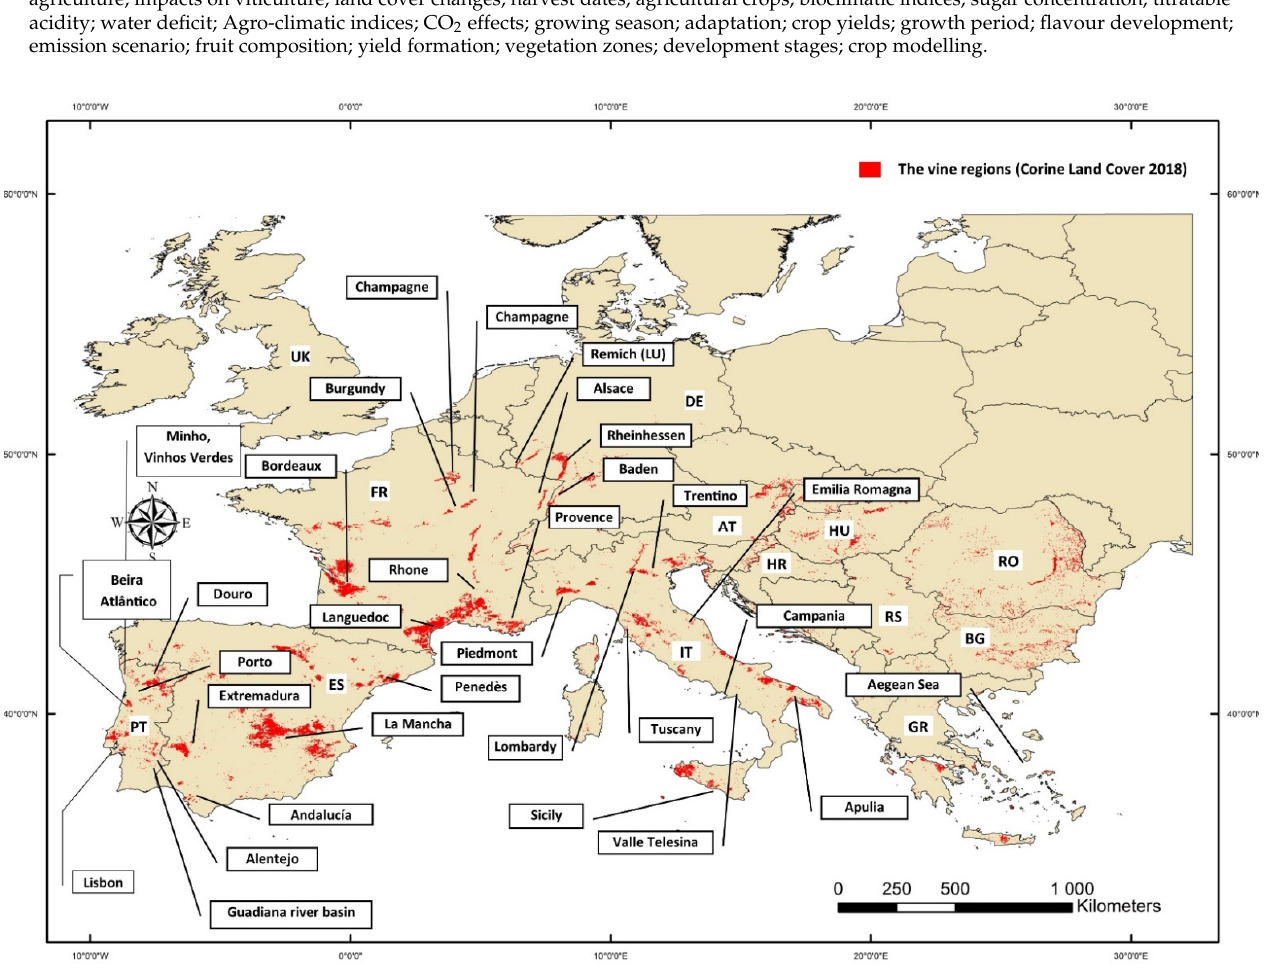
Figure 1. The vine regions referred to in this review.